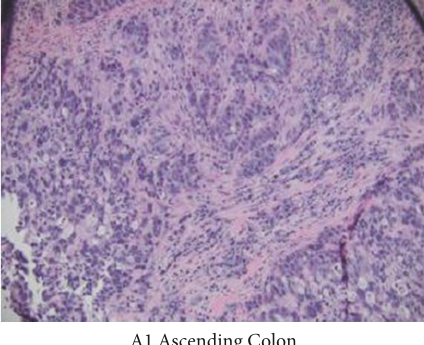
Figure 1: Cutaneous lesion in the lateral aspect of right thigh measuring 4 cm × 3 cm.